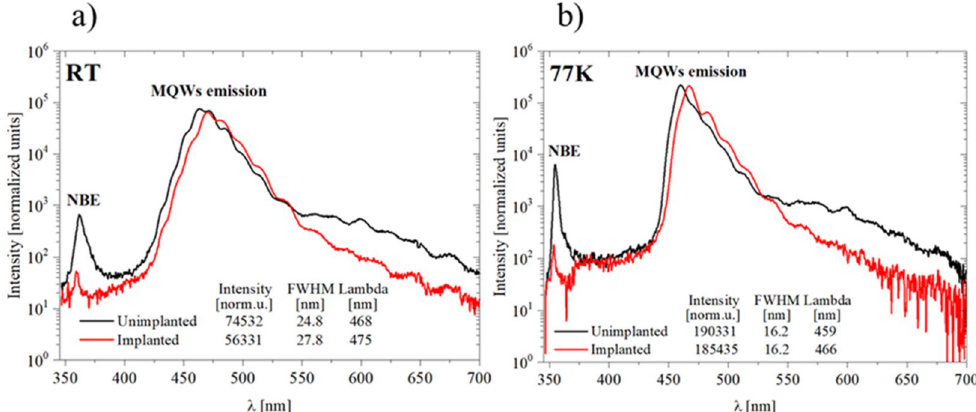
Figure 9. PL spectra collected at room temperature ( a ) and liquid nitrogen – 77 K, ( b ) of MQW structure grown on unimplanted (black line) and implanted GaN:Si (red line). PL intensity was normalized to exposure time 100